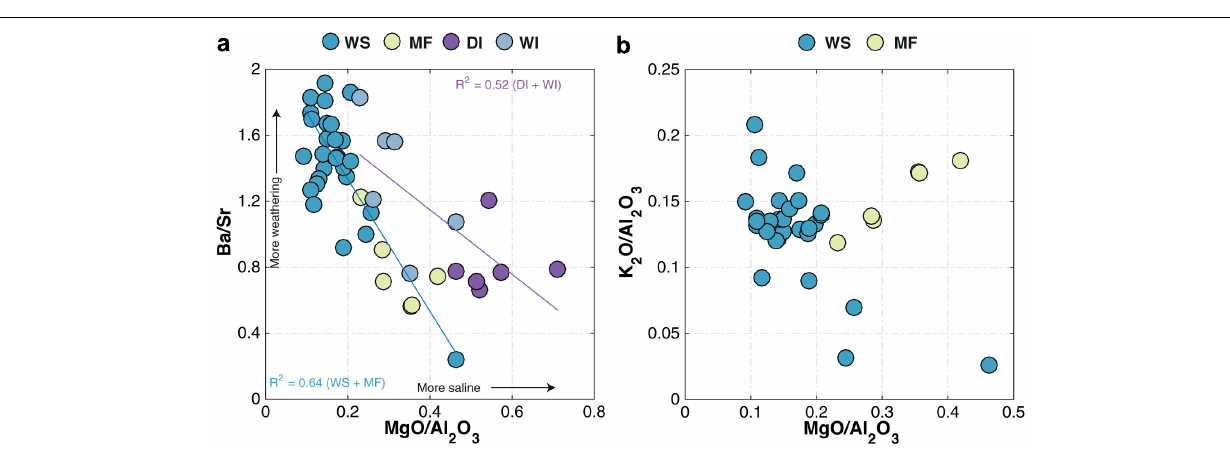
FIGURE 9 | Comparison between (a) Ba/Sr and MgO/Al 2 O 3 for WS, MF, DI, and WI samples and (b) K 2 O/Al 2 O 3 and MgO/Al 2 O 3 for WS and MF samples. WS, modern watershed; MF, modern mudflat; DI, late Quaternary dry interval; and WI, late Quaternary wet interval. The R 2 values shown in the lower left corner of (b) are for Ba/Sr versus MgO/Al 2 O 3 in WS and MF (blue), and WI and DI (purple) samples, respectively. Arrows in (b) show direction of increase in weathering intensity and salinity inferred from the Ba/Sr and MgO/Al 2 O 3 ratios,